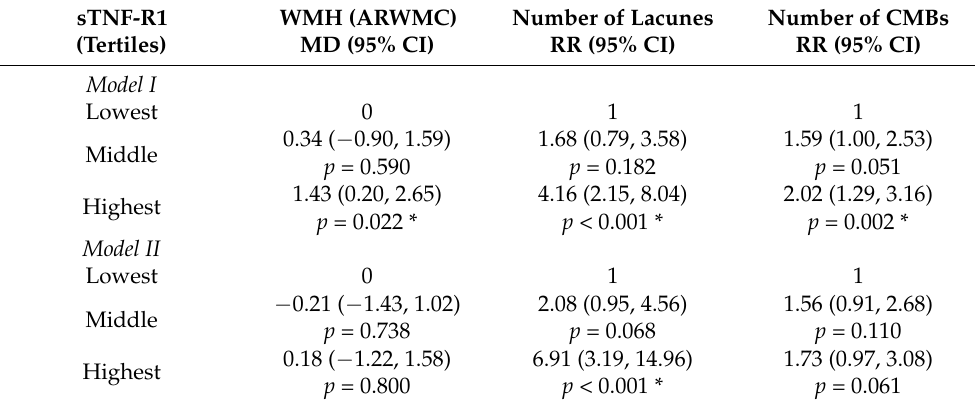
Table 2. Association between serum sTNF-R1 tertiles and CSVD markers at baseline 1